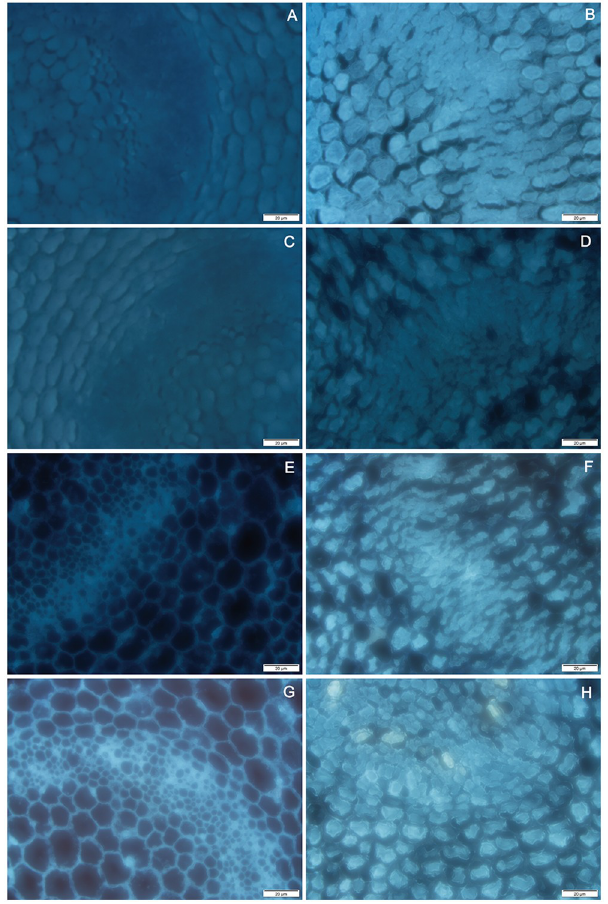
Fig 12. Fluorescent in situ localization of cytochrome C from mung bean hypocotyls in different preimbibition and dehydration states. A, C, E and G show hypocotyl tissue at 3, 6, 18 and 24 h of preimbibition, respectively. B, D, F and H show hypocotyl tissue with 3, 6, 18 and 24 h of preimbibition after 24 h of dehydration,